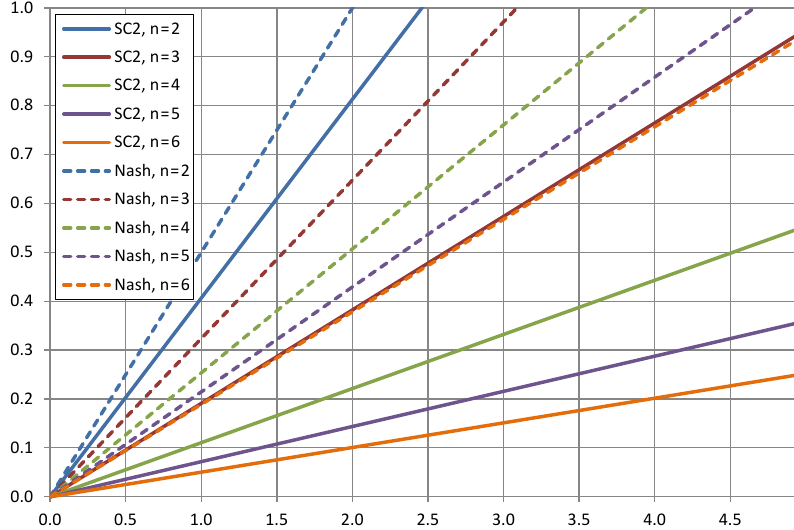
Figure 7. IUH peak values in SC2 and Nash models versus storage coefficient k .